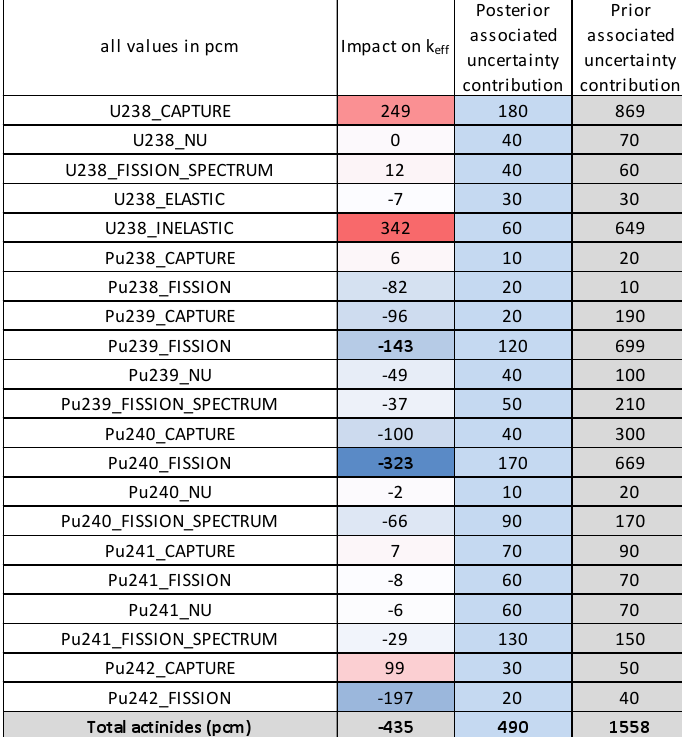
Table 3. Impact of the nuclear data trends (in pcm) on the critical mass of the ASTRID core and associated uncertainty (a priori uncertainties using COMAC-V1 nuclear data covariance are also